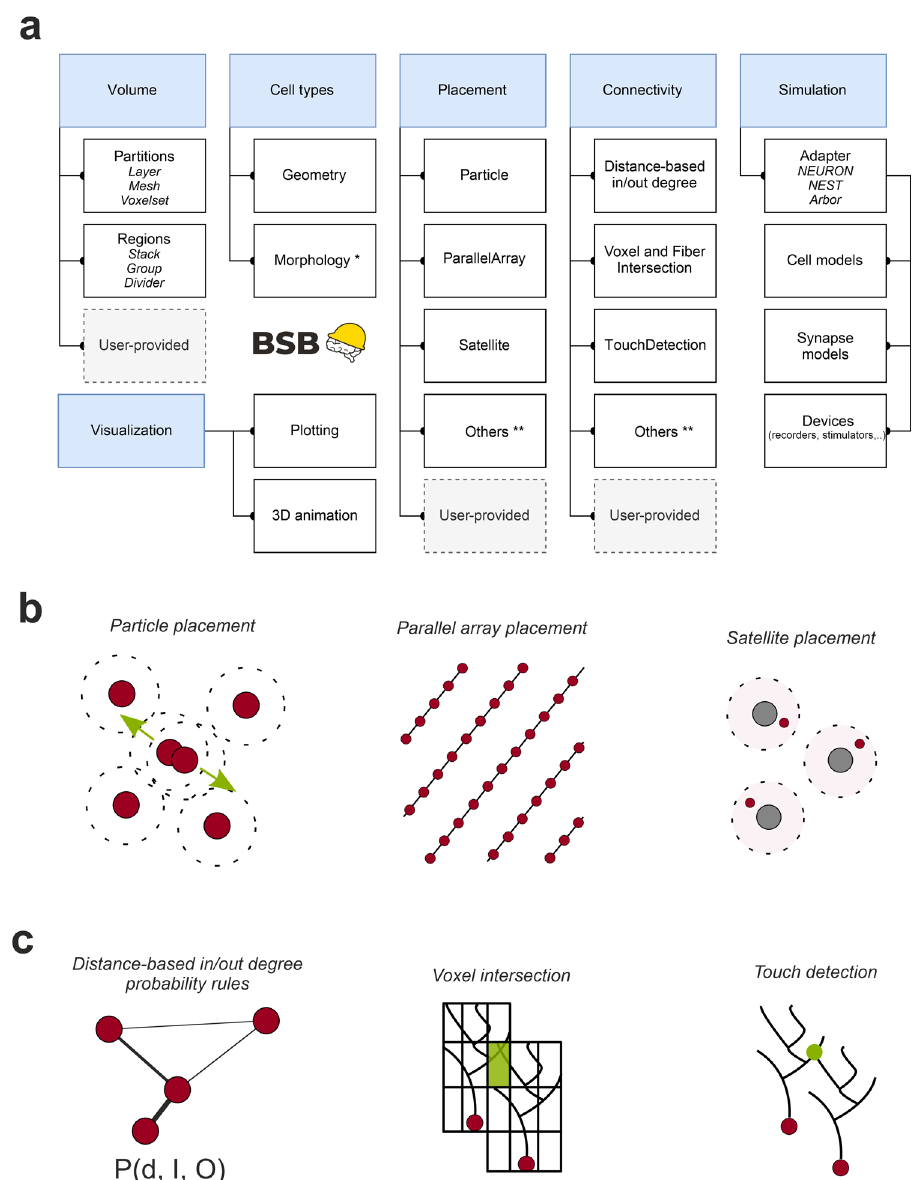
Fig. 1 The Brain Scaffold Builder. a Core BSB operations. In the reconstruction phase, BSB proceeds by sequentially de fi ning the network volume , cell types , cell placement, cell connectivity . Once neurons and fi bers are positioned, their geometries/morphologies are imported, and connection rules allow to wire them up and to build the network connectome. In the simulation phase, neuron and synapse models are linked to simulators, like NEURON in the present case, by a speci fi c adapter and interfaced to a set of devices for stimulation and recording. In the post-simulation phase, graphic tools are made available for data representation. This work fl ow is applicable to any kind of brain neuronal network. b Infographic representations of the main placement strategies available in BSB, using kd-tree partitioning of the 3D space (particle placement, parallel array placement, satellite placement). c Infographic representations of the main connection strategies available in BSB: distance-based in/out degree probability functions, voxel (or fi ber) intersection based on voxelization of morphologies, touch